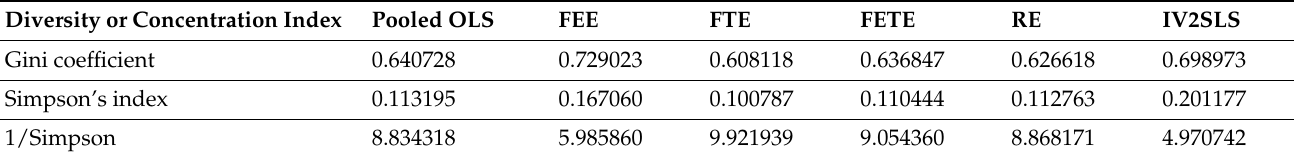
Table 5. Indexes of diversity and concentration for linear models’ emulated feature